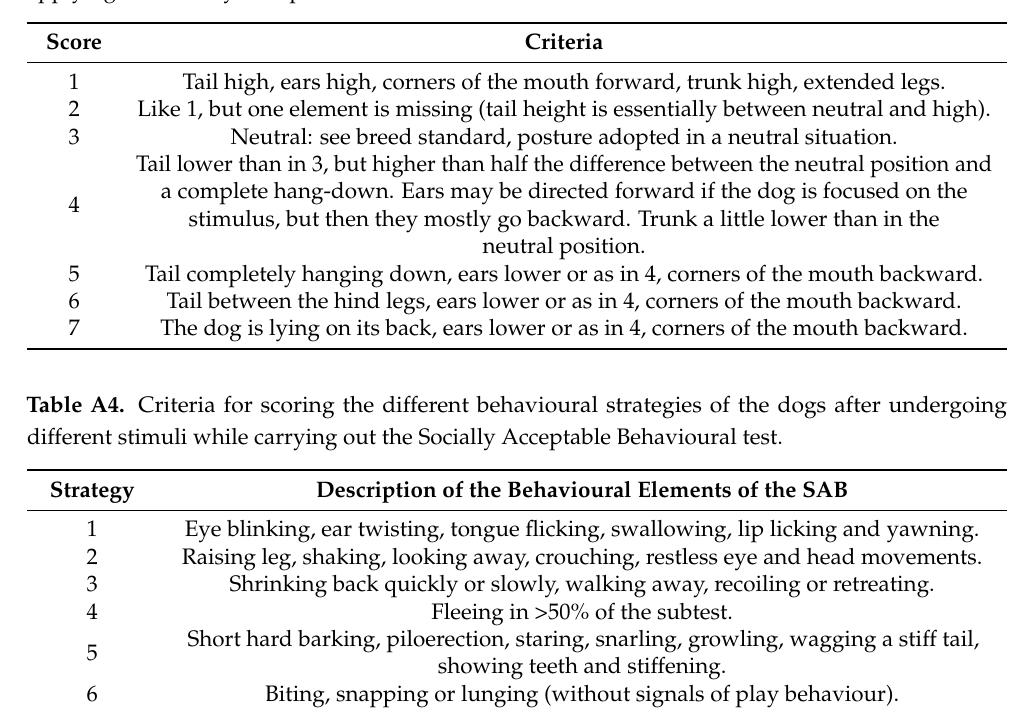
Table A3. Criteria for scoring the posture of the dogs after exposure to different stimuli while applying the Socially Acceptable Behaviour test. Score Criteria 1